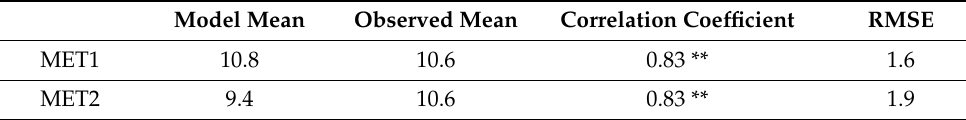
Table 3. Statistical analysis of 2 m temperature (unit: °C). Model Mean Observed Mean Correlation Coefficient RMSE MET1